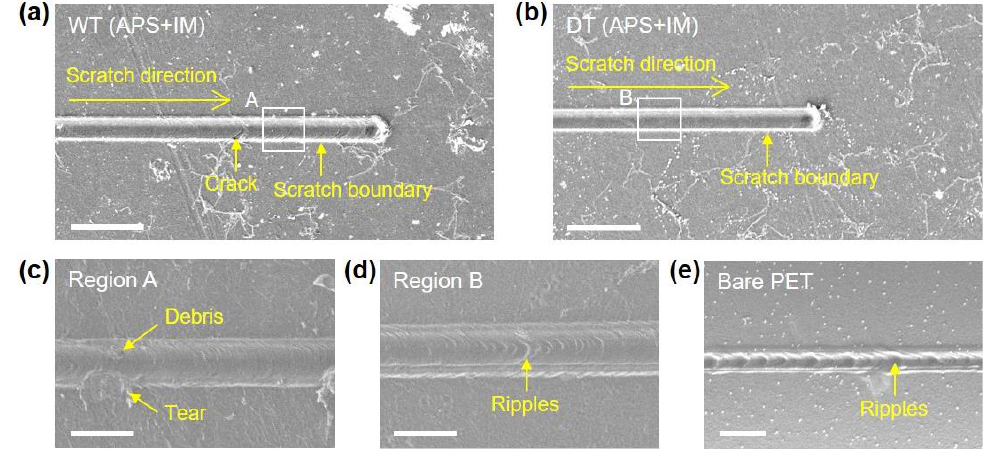
Figure 5. SEM micrographs showing the scratch traces on sample surfaces. ( a ) WT (APS + IM) and ( b ) DT (APS + IM) (scale bar: 20 µm). Enlarged images of ( c ) region A in ( a ), ( d ) region B in ( b ), and ( b ) DT (APS + IM) (scale bar: 20 µ m). Enlarged images of ( c ) region A in ( a ), ( d ) region B in ( b ), and ( e ) bare PET substrate (scale bar: 4 µm). ( e ) bare PET substrate (scale bar: 4 µ